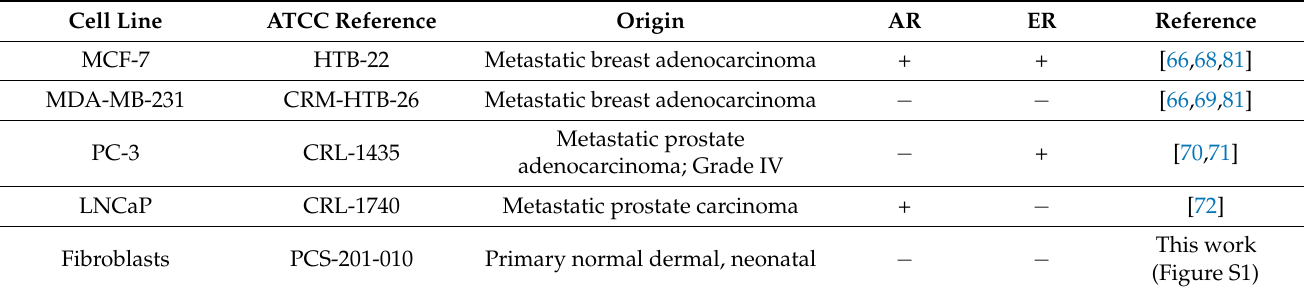
Table 1. Origin and receptor (AR, ER+, ER − ) status of the cell